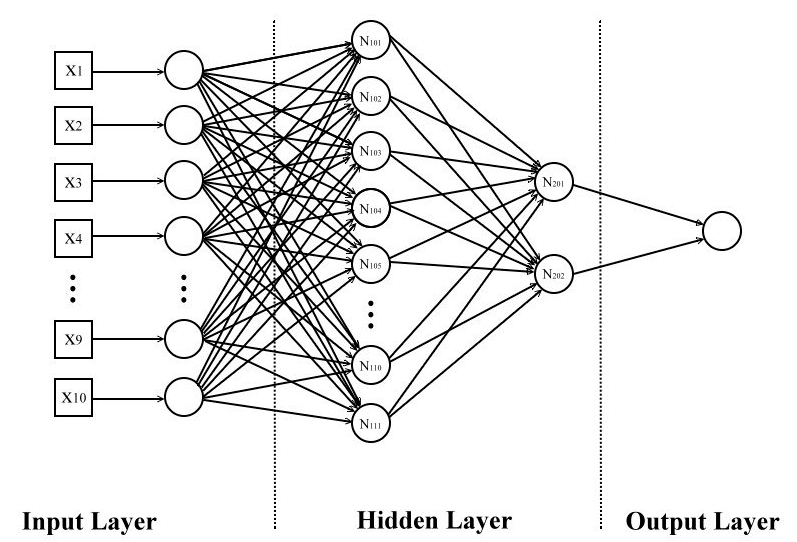
Figure 7. The structure of neural network to learn the data from the five electrodes.